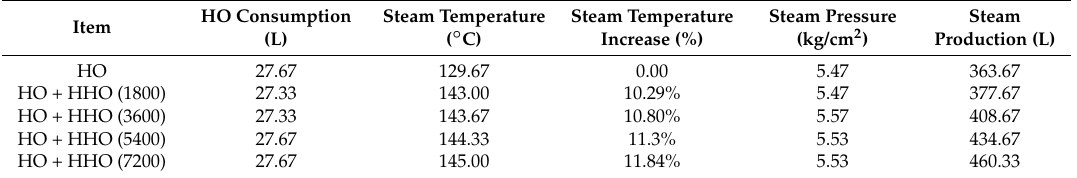
Table 7. Average HO consumptions and steam productions when combining hydrogen and oxygen mixture